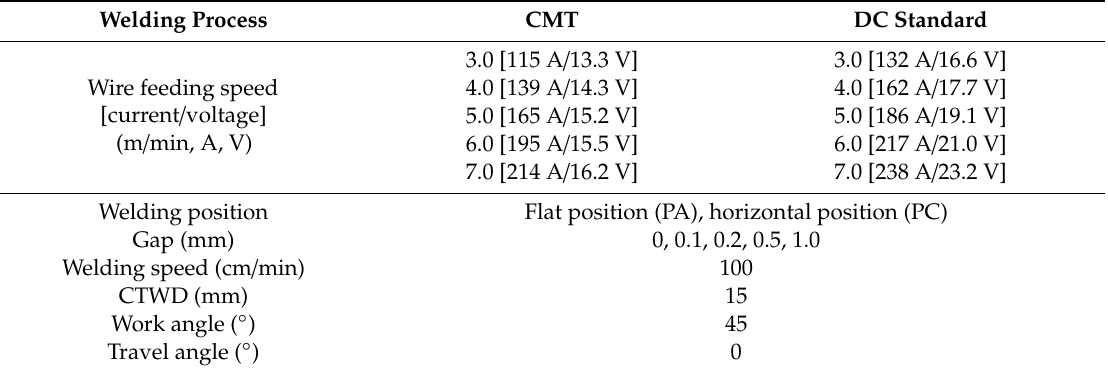
Table 2. Welding